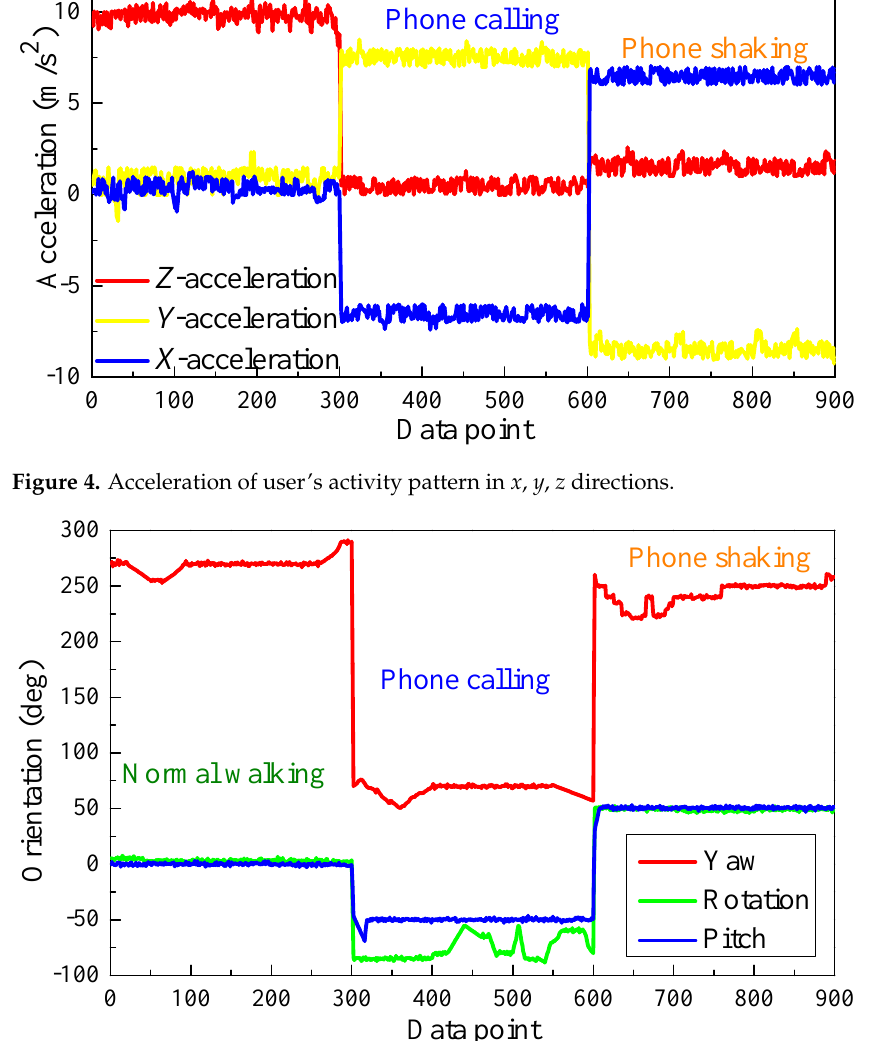
Figure 5. The smartphone states in different users’ activity